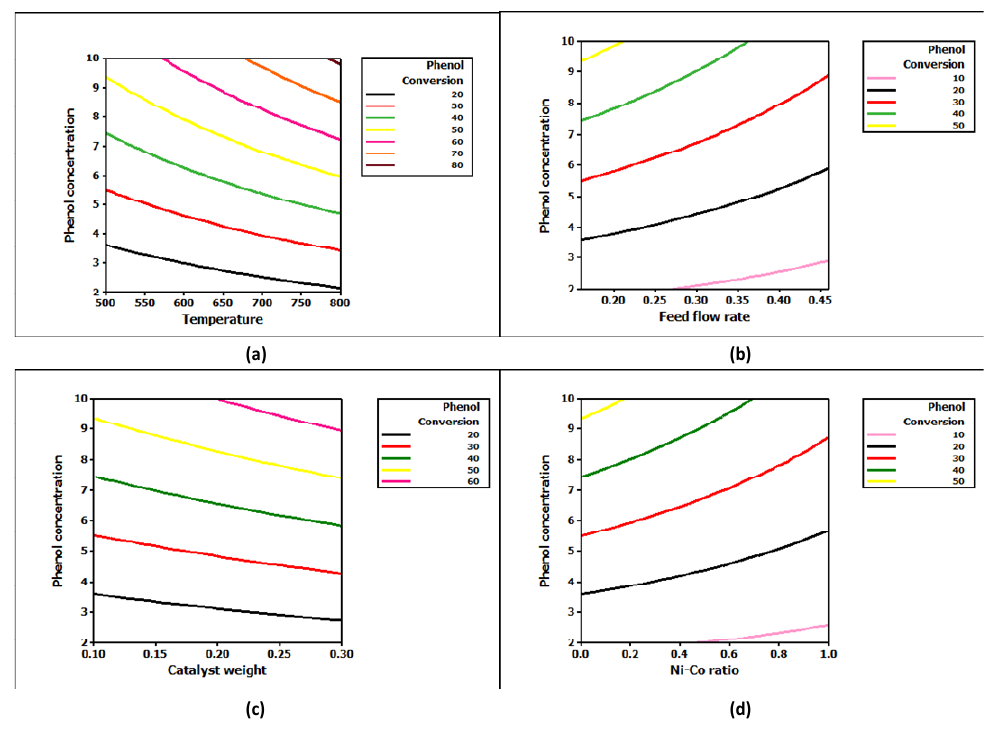
1 : ( a ) AE ; ( b ) BE ; ( c ) CE ; ( d ) DE .